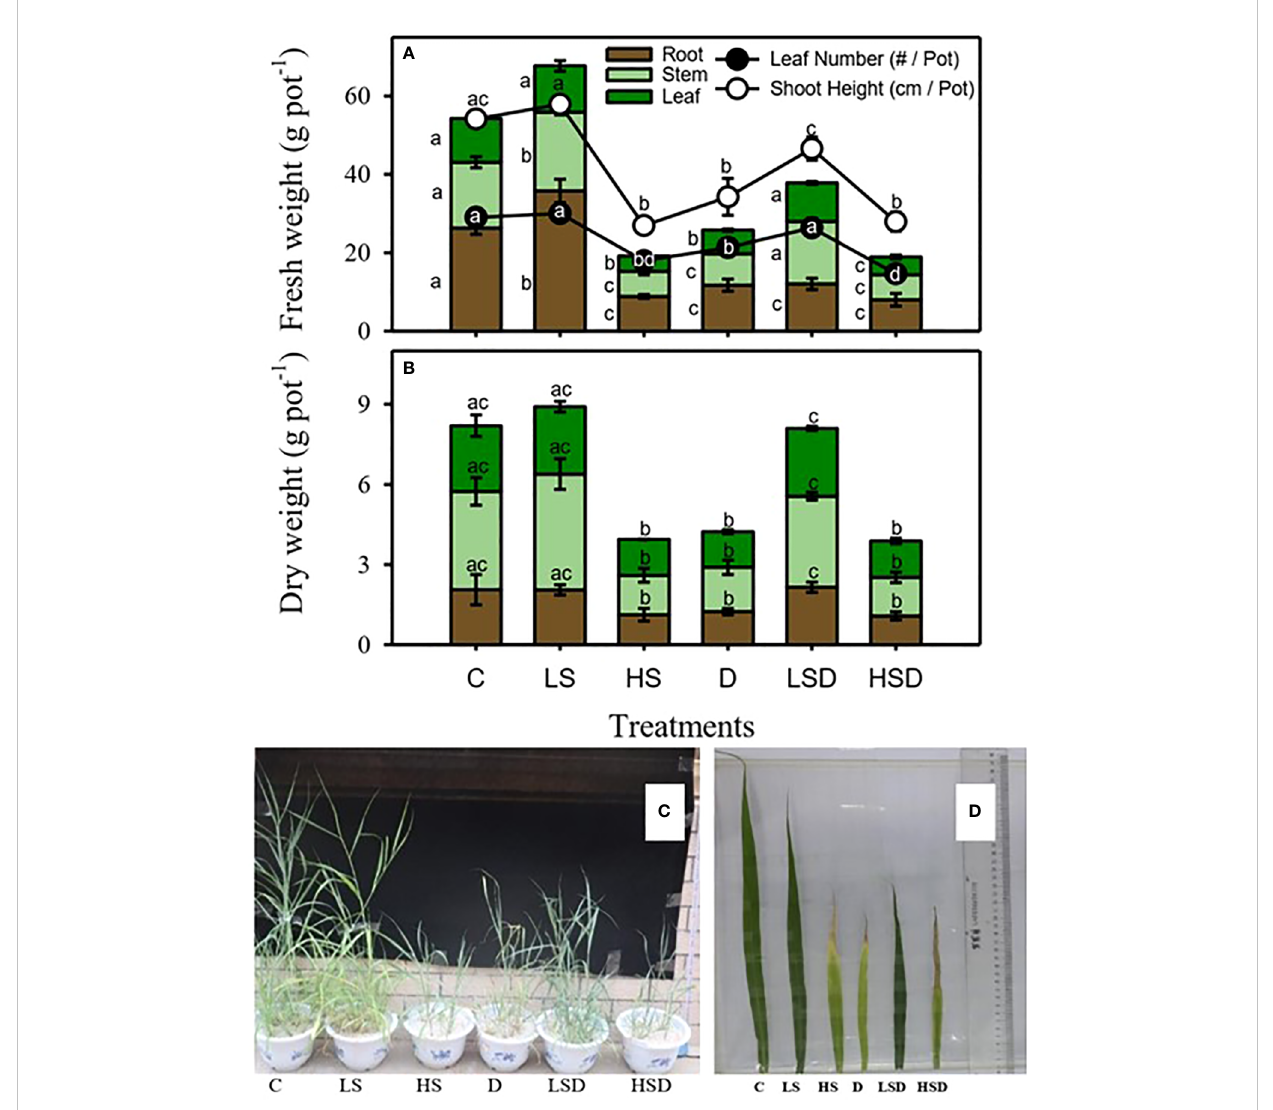
FIGURE 1 Biomass and growth of P. antidotale exposed to salt (0, 100, 300 mM NaCl abbreviated as C, LS, and HS respectively), drought (D), and combination of both (abbreviated as LSD and HSD) treatments. (A) fresh weight of leaf, stem, and root, leaf number, and shoot height. (B) dry weight of leaf, stem, and root. (C) plant growth and (D) leaf length. The values represent the means and ± S.E. (n = 3) where n is number of plants sampled from different pots. After the Bonferroni post hoc test, different letters denote signi fi cant difference at P <